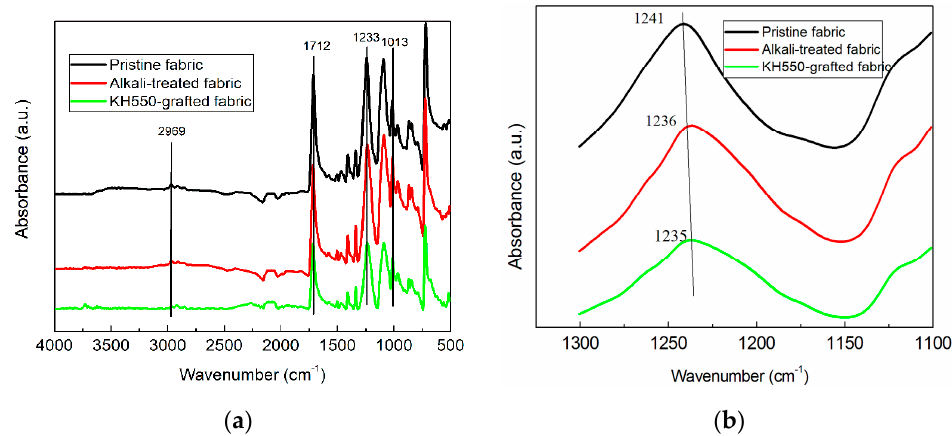
Figure 6. FTIR spectrum analysis of the fabric modified by different process modes. ( a ) wide scan spectra of FTIR; ( b ) FTIR spectrum with wavenumbers from 1300 cm − 1 to 1100 cm − 1 .